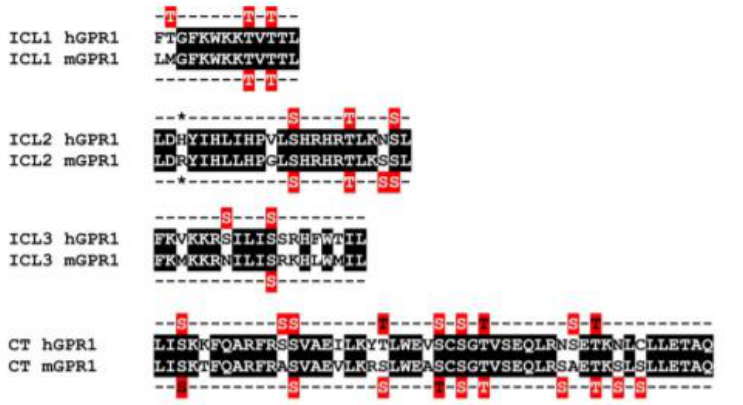
Figure 7. Sequence alignment of the ICLs and C-terminus of hGPR1 and mGPR1. Identical residues are shaded in black and S/T phosphorylation sites predicted by the NetPhos 3.1 software are highlighted in red. The 3.50 R/H residue in ICL2 is marked with a star.